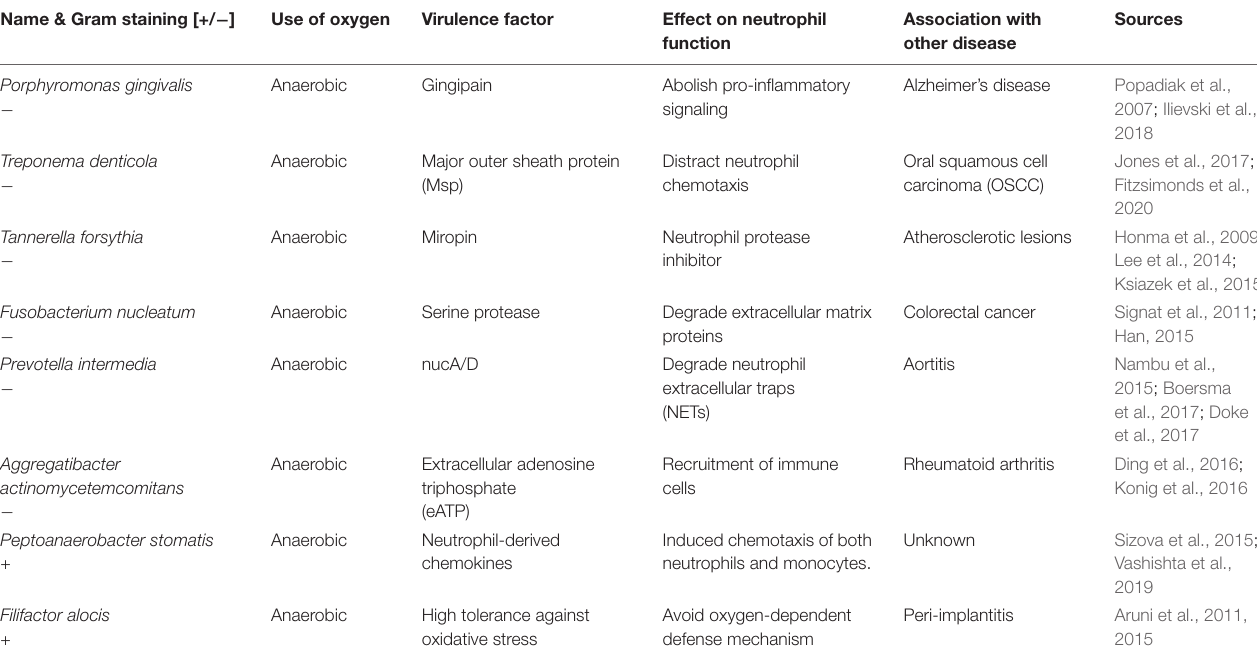
FIGURE 1 | Neutrophil defense mechanisms (A) and associated diseases (B). (A) Neutrophils can employ numerous strategies in order to eliminate pathogens, including the formation of neutrophil extracellular traps, destined to capture and eliminate, internalization (phagocytosis) and the release of a high variety of granule contents (e.g., receptors, proteases and enzymes). The utilization of secretory vesicles provides an easy to mobilize source of receptors crucial for pathogen recognition (TLRs) and cell fate determination (apoptosis regulators). (B) Periodontal pathogens have been associated with multiple other diseases which resulted in increased attention. Affected organs and systems (non-exhaustive): brain (Alzheimer’s disease), mouth (periodontitis, oral squamous cell carcinoma, peri-implantitis), esophagus (esophageal cancer), vascular system (aortitis, atherosclerosis), pancreas (pancreatic cancer), colon (colorectal cancer), uterus (preterm birth), genitals (bacterial vaginosis), joints (rheumatoid arthritis). TABLE 1 | Identified prevalent pathogens associated with periodontitis